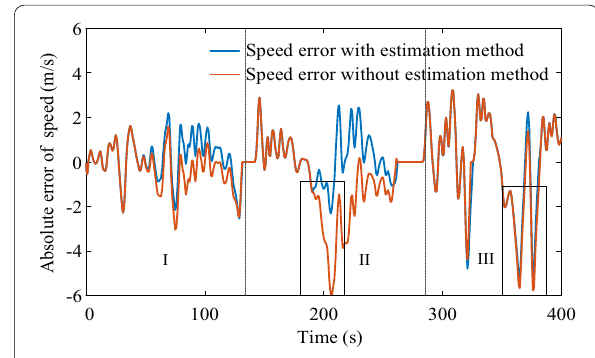
Figure 16 Errors of the speed tracking